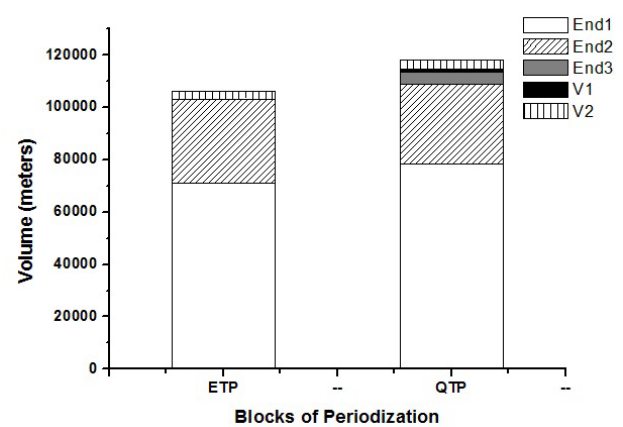
Figure 1. Training intensity distribution for each block of periodization. The bars indicate the volume swam in each zone’s intensity. The white bars indicate the volume at End1; the diagonal dashed bars indicate the volume at End2; the filled gray bars indicate the volume at End3; the filled black bars indicate the volume at V1; and the vertical dashed bars indicate the volume at V2, as proposed by Santhiago et al. (2011).